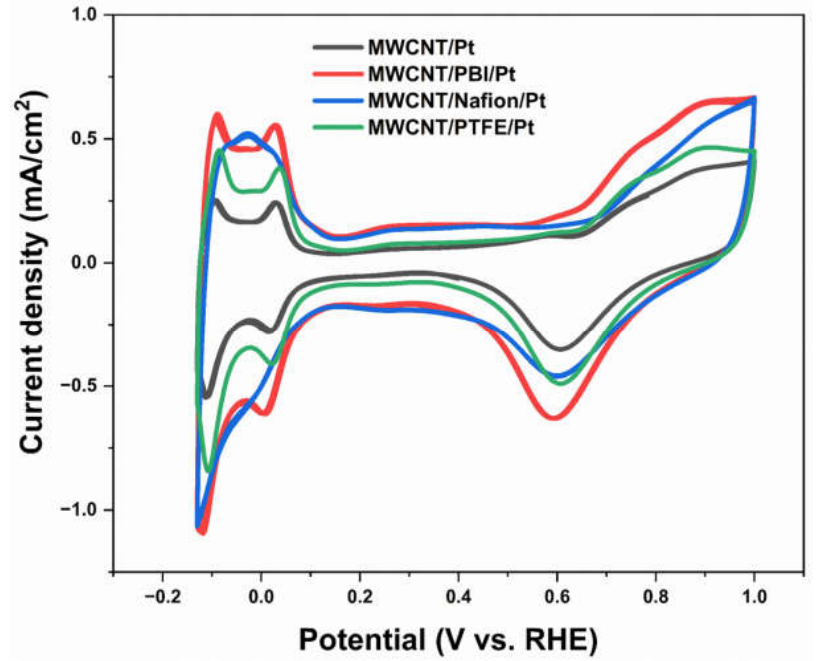
Figure 10. Cyclic voltammogram (CV) of electrocatalysts in oxygen gas saturated 1.0 M H 2 SO 4 using 10 mV/s scan rate. Table 1. The electrochemical performance of different electrocatalysts.